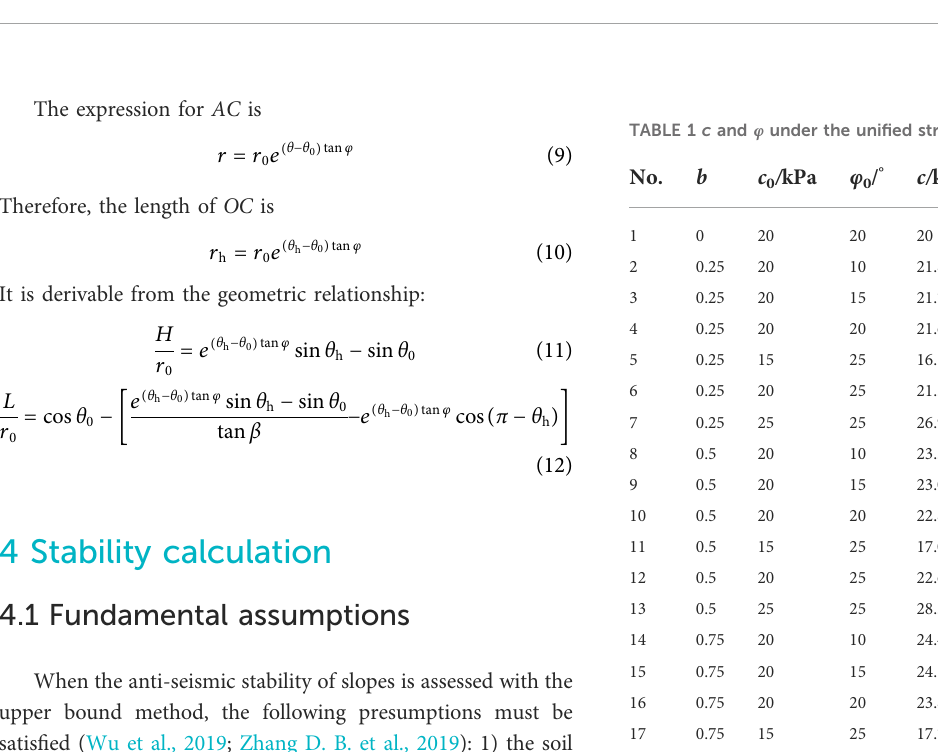
FIGURE 2 Effect of parameter b on c and φ .